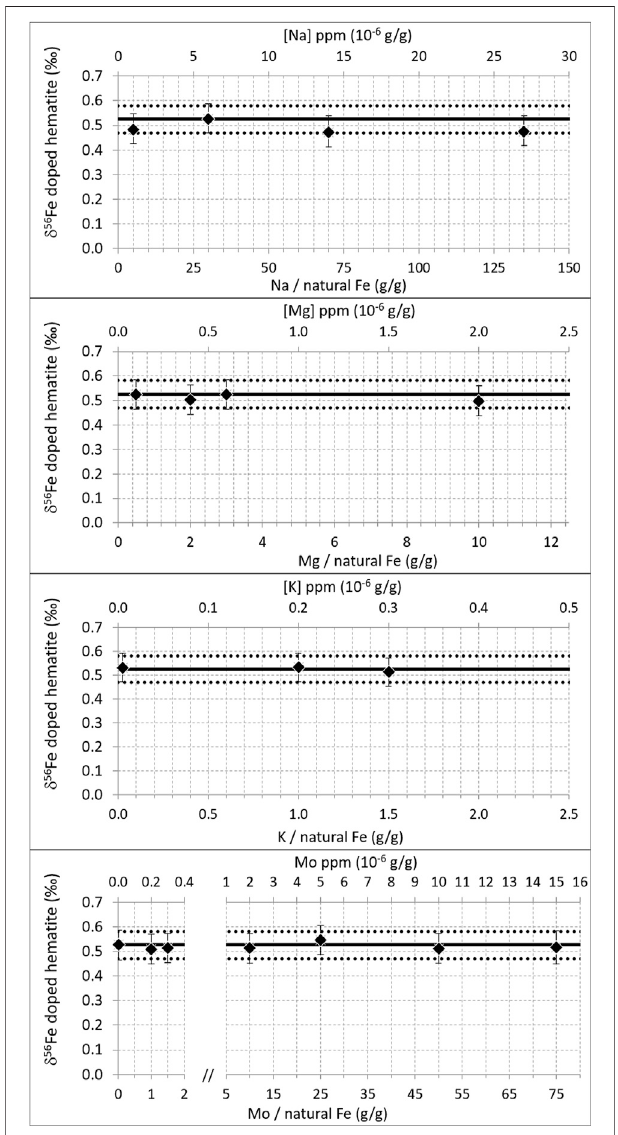
FIGURE 4 | δ 56 Fe of hematite (200 ppb natural Fe) doped with variable amounts of Na, Mg, K, and Mo. Diamonds are the averages of duplicate measurements. Error bars are 2 standard deviations of the duplicate measurements or the long-term internal precision (2SD) of our instrument (0.06 ‰ ), whichever the greatest. The horizontal black lines show the δ 56 Fe of pure (un-doped) hematite measured during the same analytical session; mean value (solid line) ± 2 standard deviations (dotted lines).